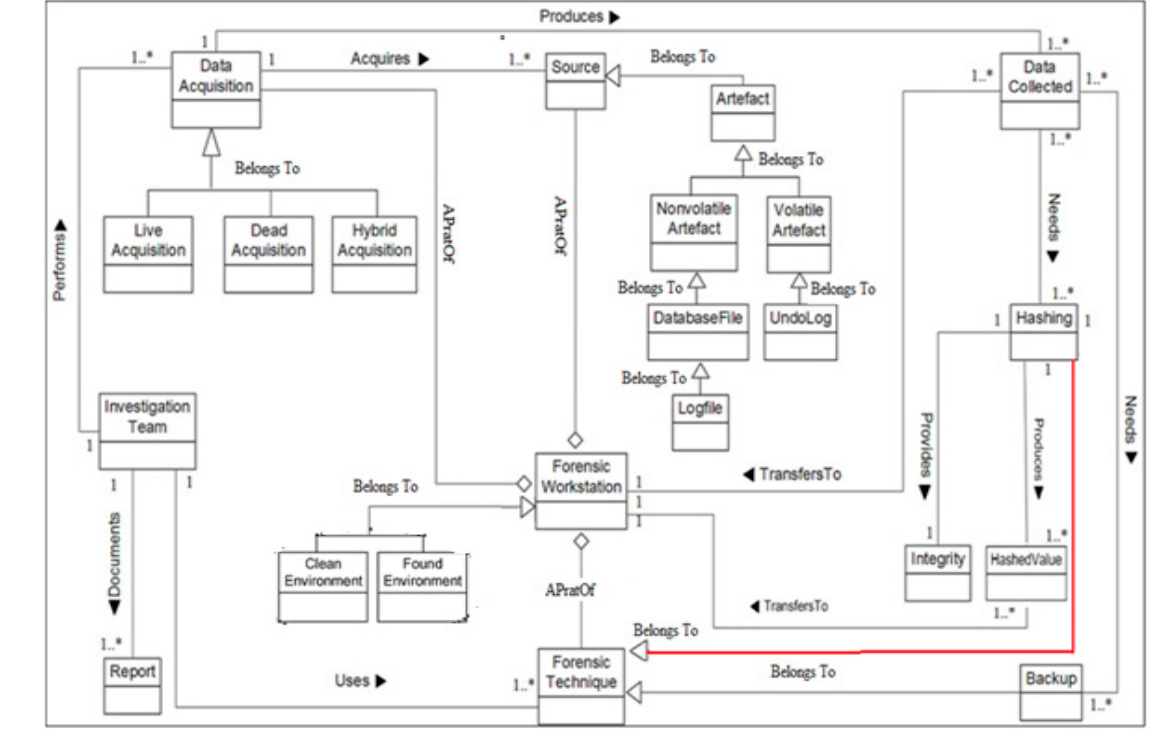
Figure 7. Validated DBFIM Artifact Collection Class 2.